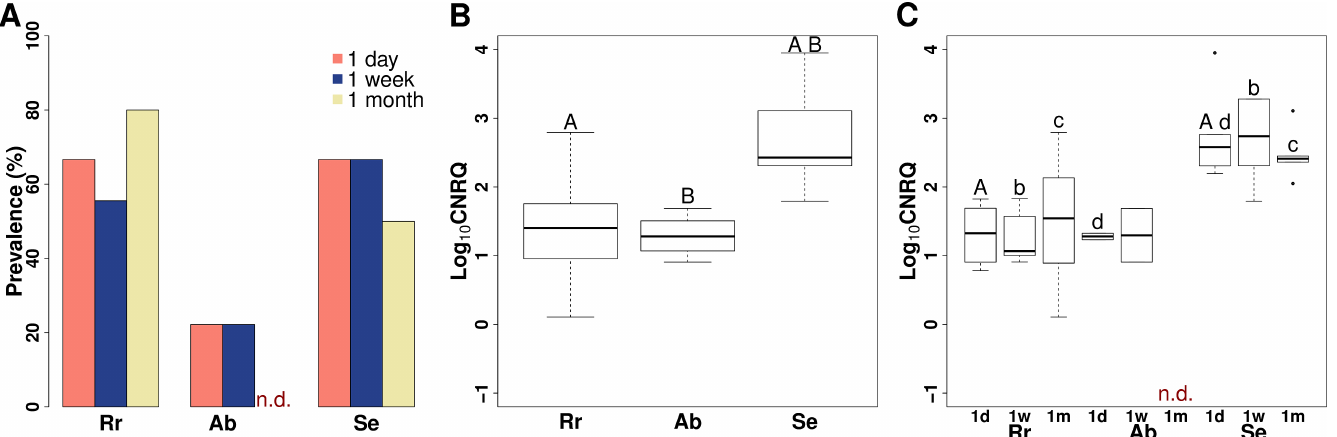
Fig 3. Prevalence and intensity of Myxoboluspseudodispar in fish blood in exposure trial #2. (A) Prevalence of the parasite in host species in the relation of sampling time. (B) Boxplot of infection intensity in different fish species. Significant differences A: p < 0.001, B: p = 0.003. (C) Boxplot of infection intensity by fish species and sampling time. Letters above boxes indicate significant differences: A: p = 0.002, b: p = 0.035, c: p = 0.020, d: p = 0.015. Rr: common roach Rutilus rutilus ; Ab: common bream Abramis brama ; Se: rudd Scardinius erythrophthalmus ; n.d. = no data; Log 10 CNRQ: log10 transformed, calibrated normalized relative quantities of parasite DNA based on qPCR